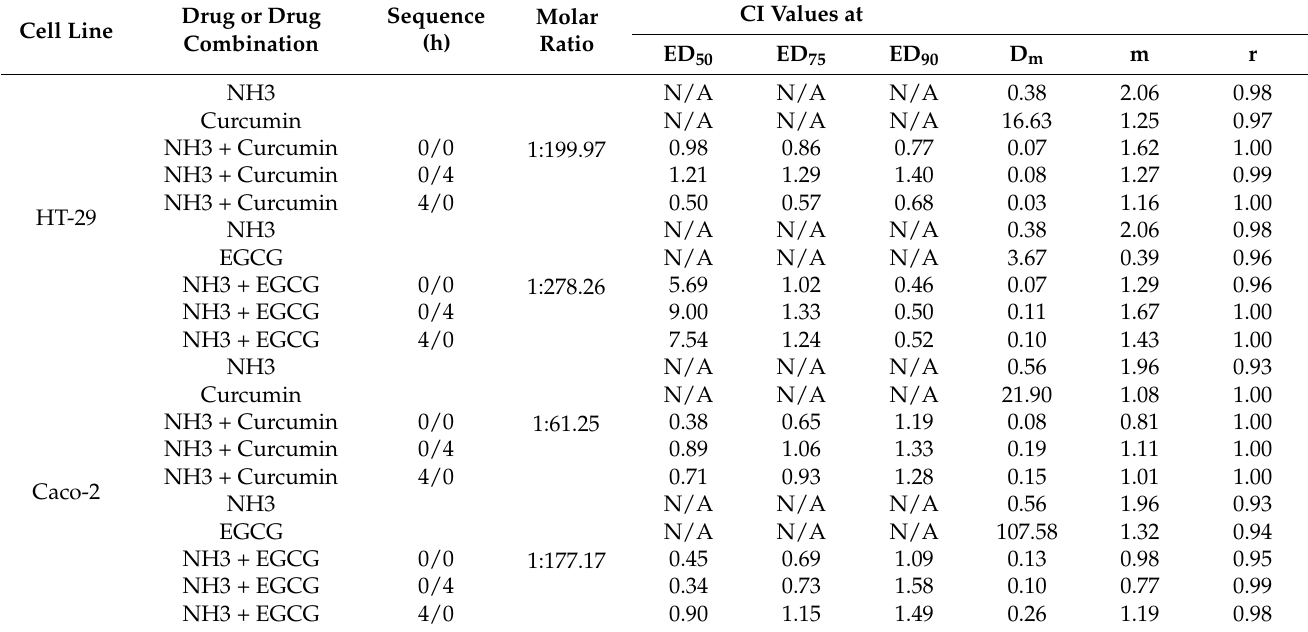
Table 8. CI values (at ED 50 , ED 75 , ED 90 ) and dose-effect parameters (median effect dose Dm, the exponent defining the shape of the dose–effect curve m, correlation coefficient r) applying to combinations of NH3 with curcumin and EGCG in the HT-29 and Caco-2 cell